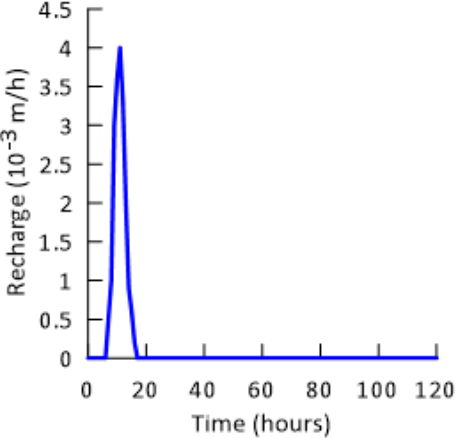
Figure 7. The amount of hypothetical recharge applied to the model. Table 1. The assumed specifications for different conduit networks .